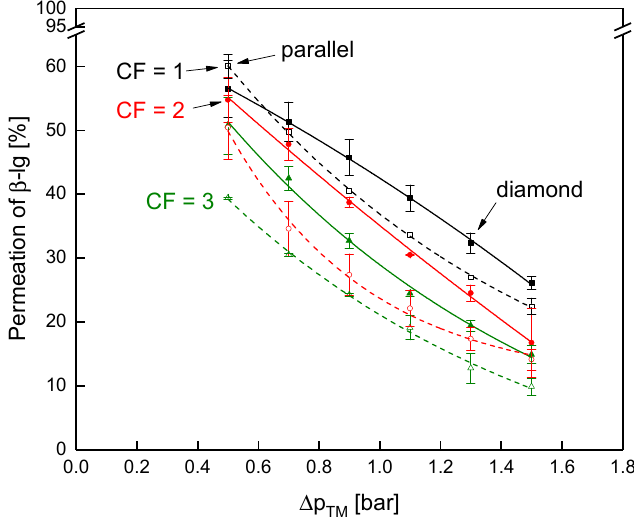
Figure 14. Permeation of β -lg as a function of the transmembrane pressure for the parallel (dashed lines and open symbols) and the diamond spacer (continuous lines and full symbols) during MF of skim milk at CF 1 to 3. Error bars represent the standard deviation of two individual experiments. Data of the diamond spacer was adapted from Hartinger and Kulozik [14].